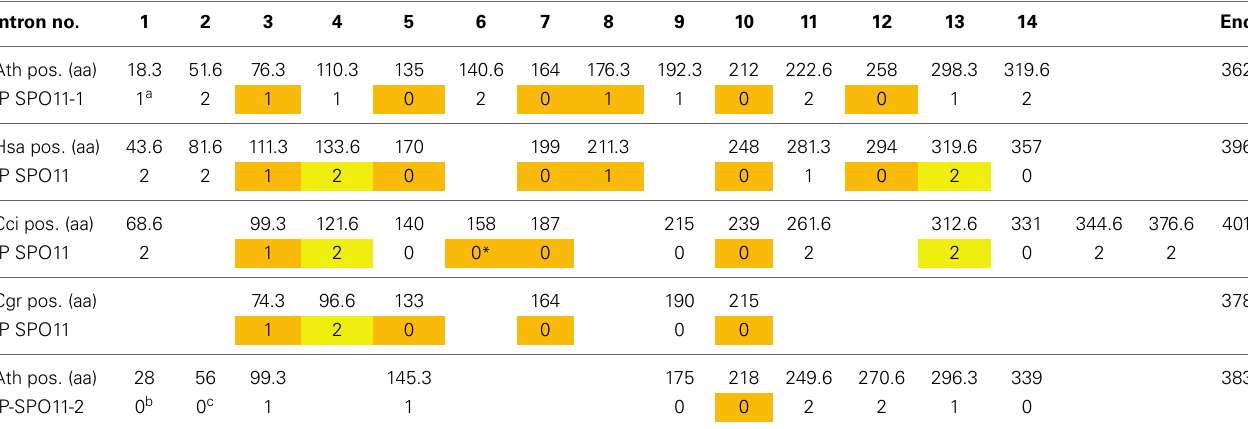
Table 1 | Intron localization of A. thaliana , H. sapiens , and the SPO11 genes from the two fungi C. cinerea (Basidiomycota) and C. grayi (Ascomycota) with respect to their corresponding amino acid sequence positions. Intron no. Ath pos.